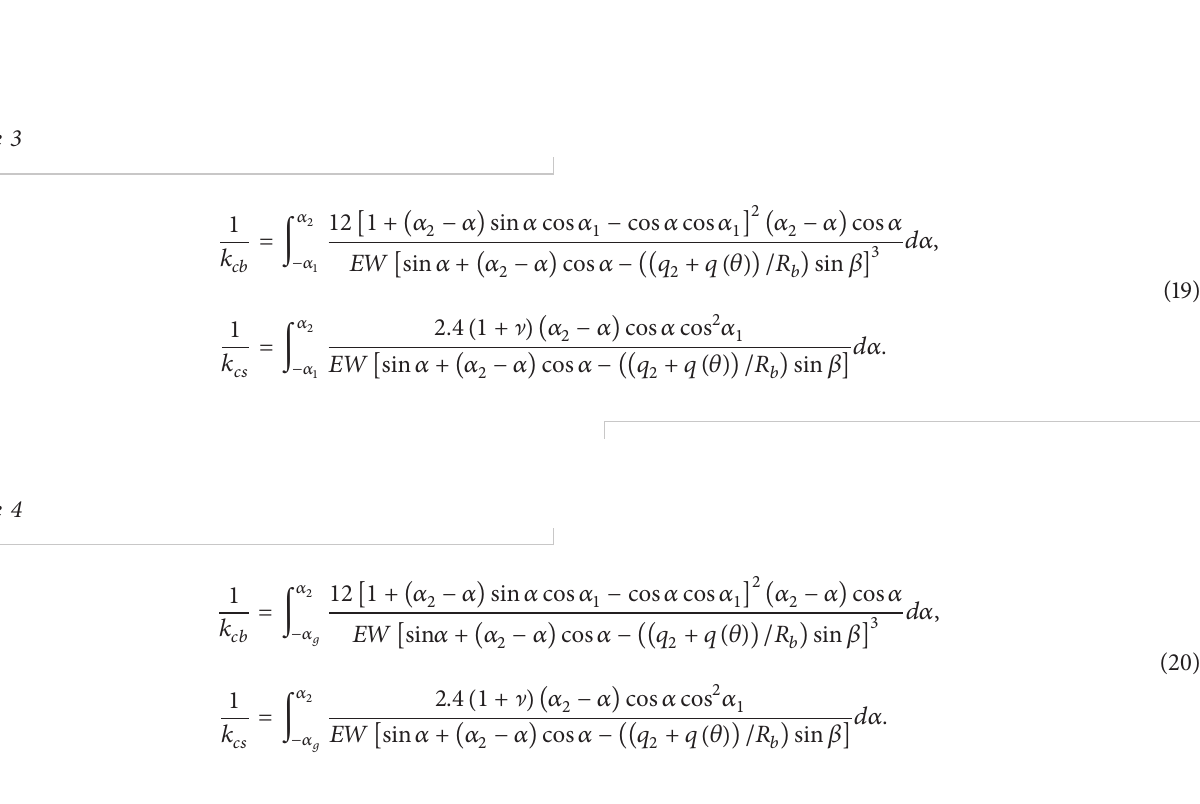
Figure 4: Different deterioration levels before